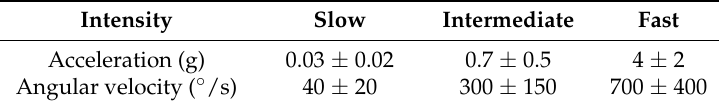
Table 1. Main kinematic characteristics of the imposed movements.